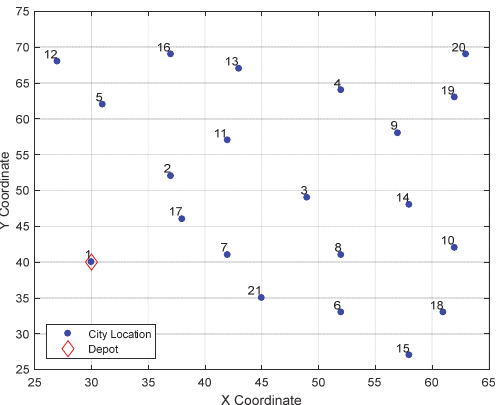
Fig. 3. Location of delivery centers and central